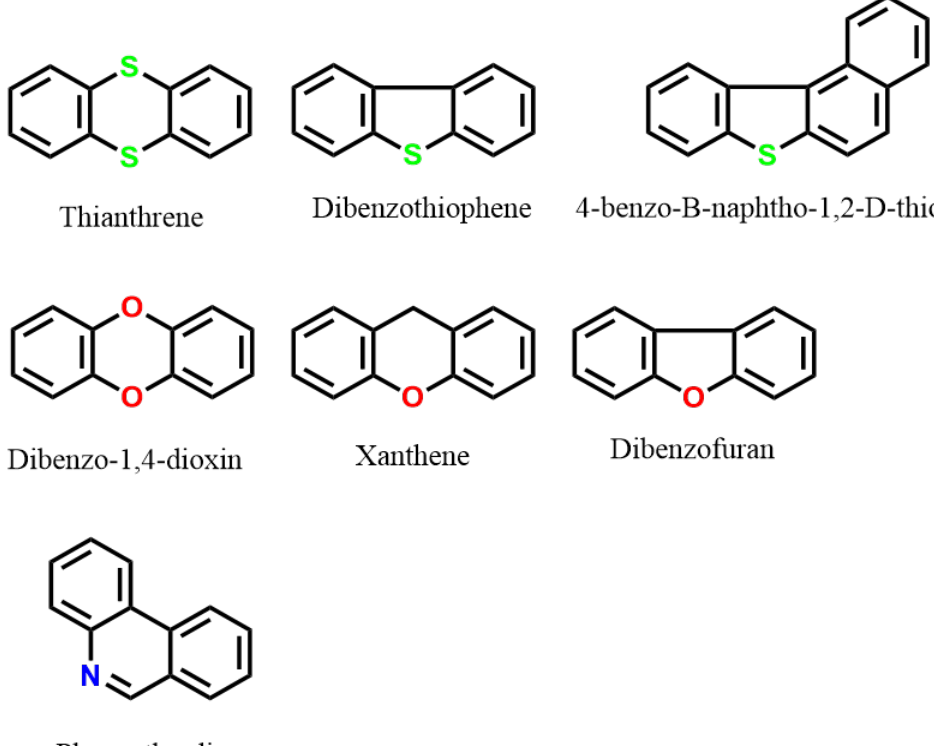
Figure 7. Heteroatoms containing three- and four-ring model compounds that eluted in the Aro-2 fraction. (The green color indicates sulfur atoms, red color oxygen atoms and blue color nitrogen.)